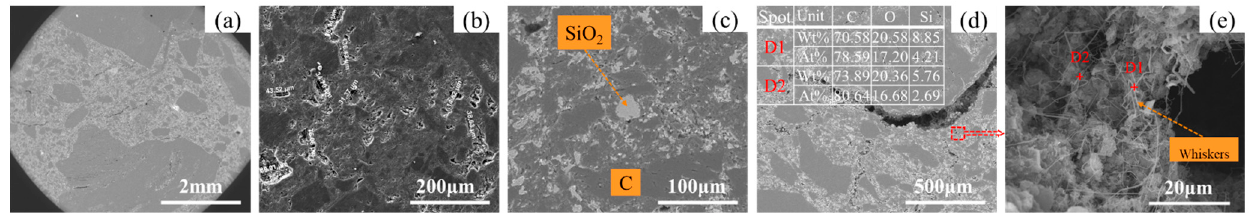
Figure 10. ( a – e ) Microscopic morphology of the original brick D under different scaleplates.